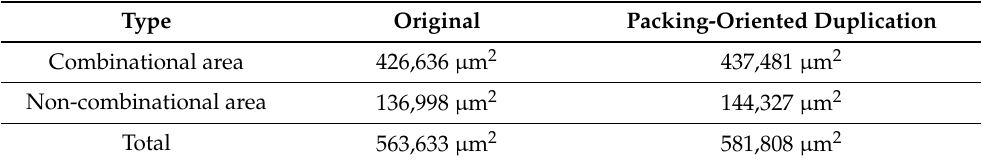
Table 1. Cell area of our VLIW architectures which is modified to detect soft errors.